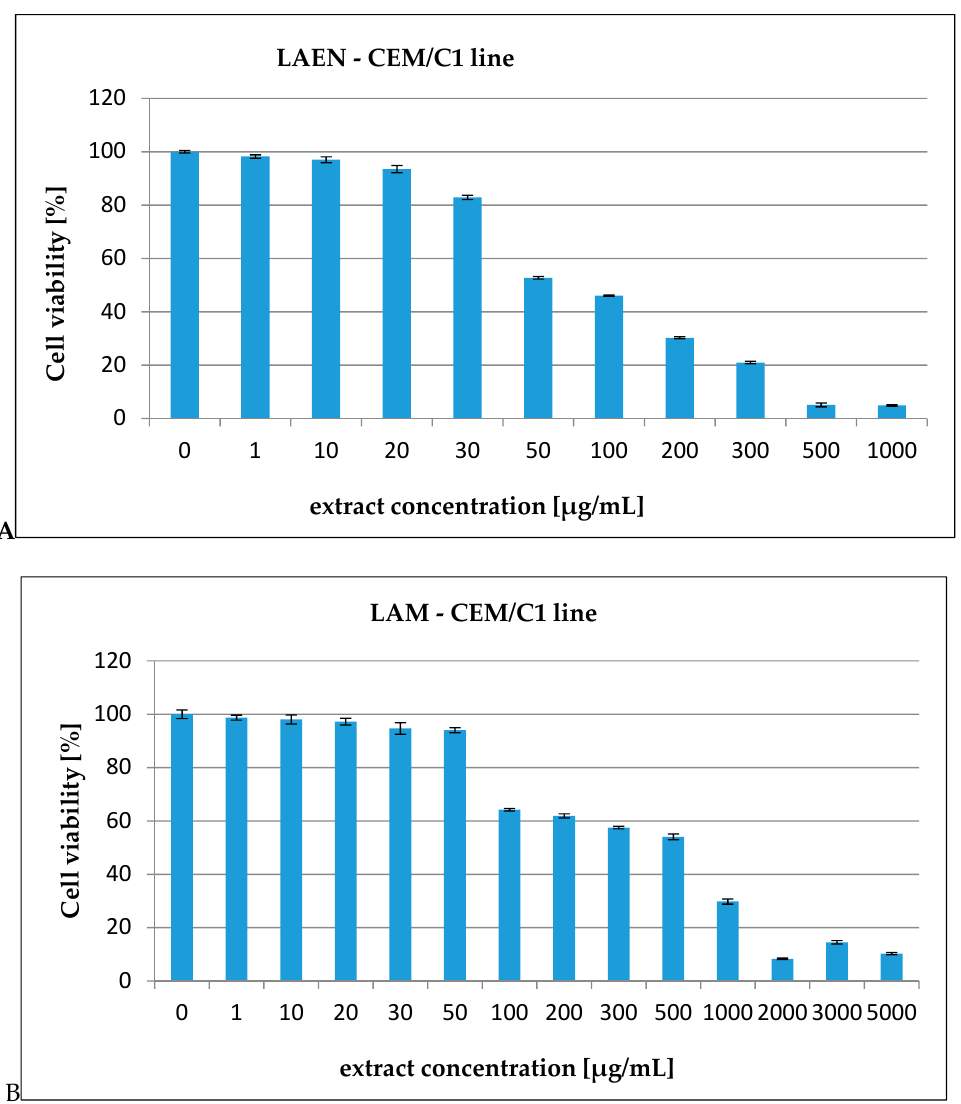
Figure 7. The valuation of the CEM/C1 cell line viability exposed to 24 h of increasing concentrations of: ( A )—LAEN extract and ( B )—LAM extract.